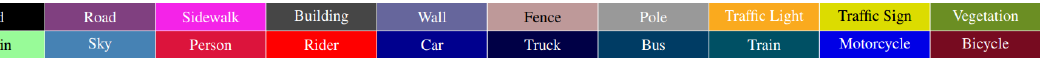
Figure 12. Cityscapes color